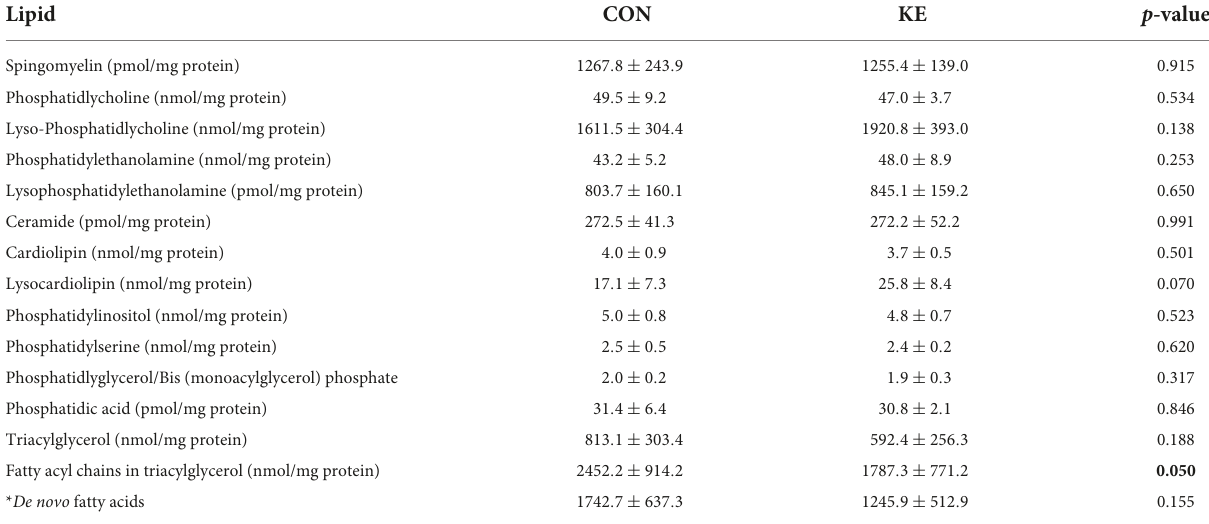
TABLE 3 Skeletal muscle lipidomic